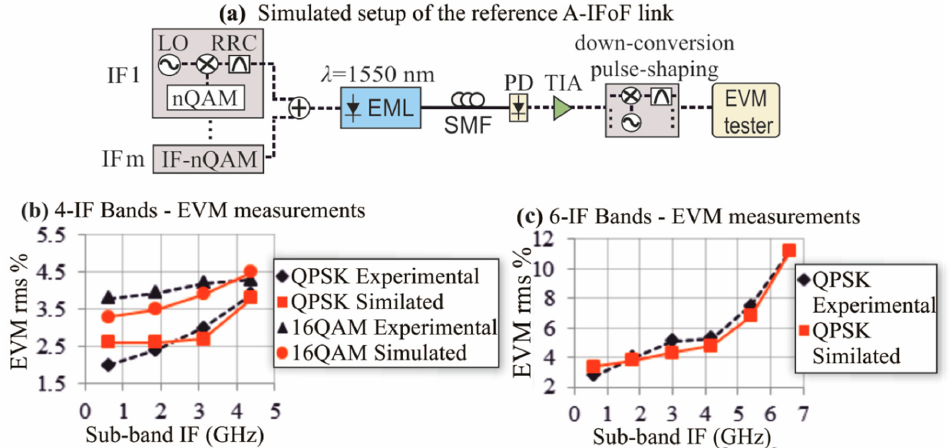
Figure 3. ( a ) Simulated setup of the reference analog IFoF optical link using the matched EML and SMF models. Matching of the experimental and simulated EVM performance of the SC modulated A-RoF link for: ( b ) 4-IF bands and ( c ) 6-IF bands after 7 km fiber transmission.